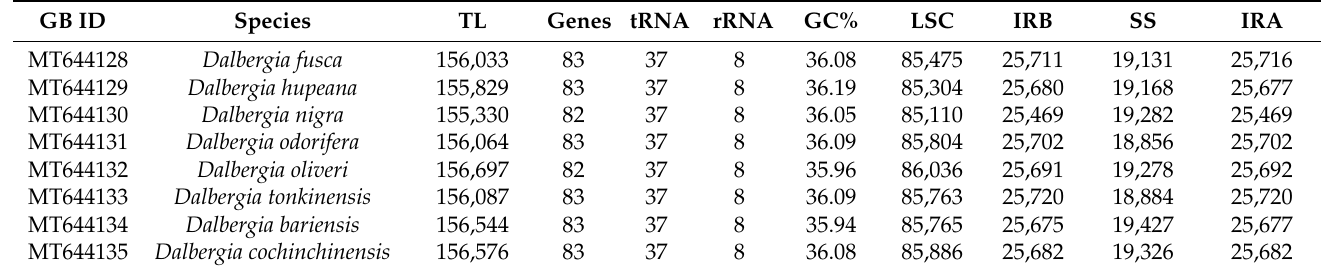
Table 1. Summary of the complete chloroplast genomes sequenced for this